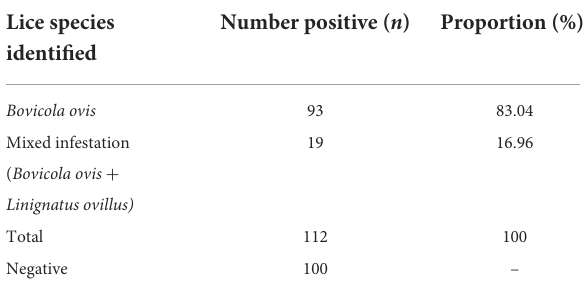
TABLE 2 Species composition of lice species in Sayint district, South Wollo,